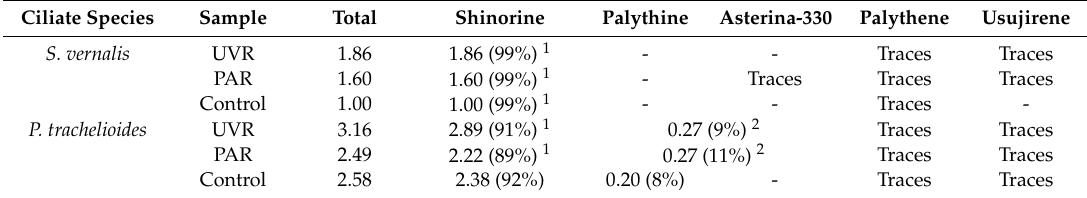
Figure 1. Living individuals of Vorticella chlorellata ( a – c ), Stokesia vernalis ( d ), and Pelagodileptus trachelioides ( e , f ): ( a ) Overall view of an intact stalked individual after photosynthetically active radiation (PAR) (experiment (exp) 1); ( b ) unusual globular appearance of the cell 48 h after the UV treatment (exp 3), with the distorted myoneme (stalk protein) visible (arrow); ( c ) V. chlorellata attached to colonies of Botryococcus braunii ( d ), showing the right lateral view, where the arrows point out to the unique “packages” of algal symbionts; ( e ) total view, showing the prominent proboscis and trunk; and ( f ) left lateral view of an individual without proboscis after 6.5 h under ultraviolet radiation (UVR) (exp 1), where the arrow points to the stump of the proboscis left over, the symbionts were accumulated in the posterior cell portion. A, algal symbionts; B.b. , colonies of Botryococcus braunii ; M, myoneme of the stalk; P, proboscis; T, trunk, V.c ., individual of V. chlorellata . Scale bars: 50 µ m ( a – e ) and 10 µ m ( f ). Table 1. Concentrations of mycosporine-like amino acids (10 − 5 µ g µ g − 1 ciliate dry weight) in individuals of Stokesia vernalis ( n = 14–16) and Pelagodileptus trachelioides ( n = 48–54) collected after exposure to UVR and PAR and in the control (exp 1). Traces: concentrations < 1% of the total. Percentages in brackets = % of the concentration of a specific mycosporine-like amino acid (MAA) in the total concentration of MAAs